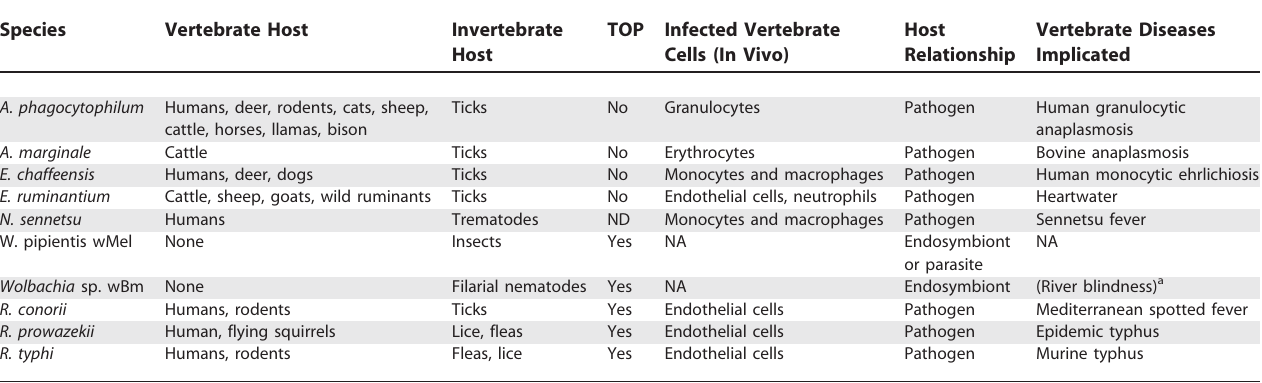
Table 1. Biological Characteristics of the Rickettsiales